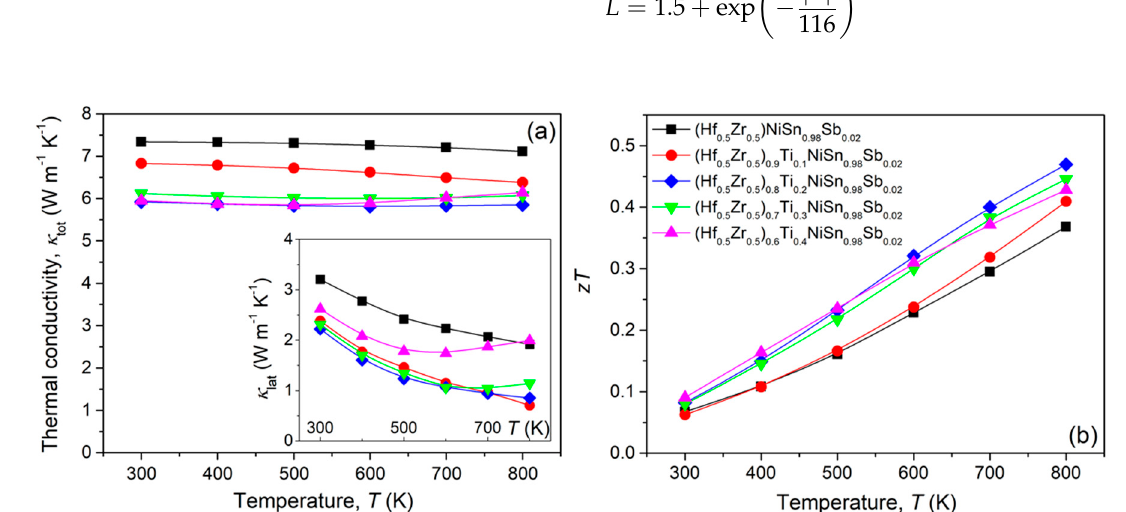
Figure 4. Temperature-dependent ( a ) total thermal conductivity ( κ tot ) and ( b ) dimensionless figure of merit ( zT ) for the sintered bulks of (Hf 0.5 Zr 0.5 ) 1 − x Ti x NiSn 0.98 Sb 0.02 ( x = 0, 0.1, 0.2, 0.3, and 0.4). Inset of ( a ) is the temperature dependence of lattice thermal conductivity ( κ lat ).